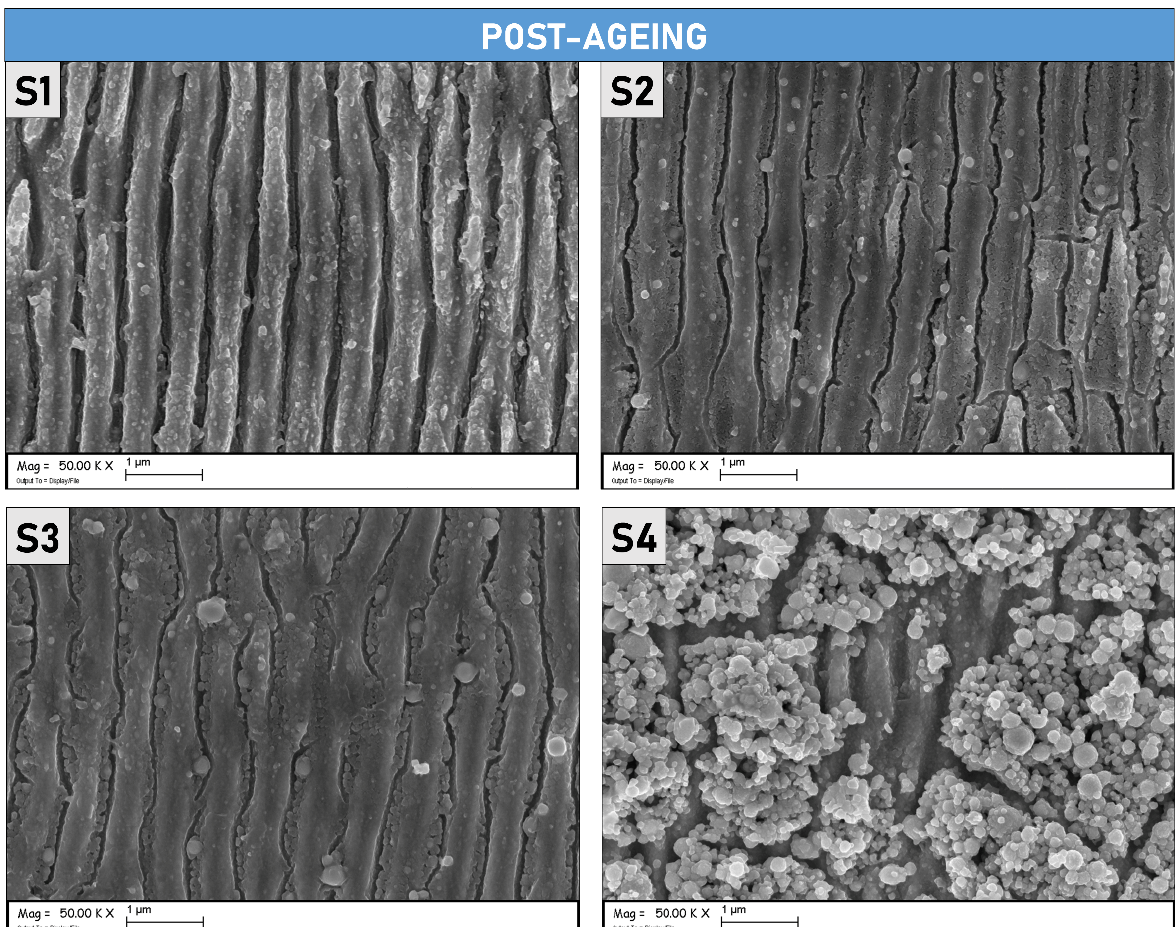
Figure 10. SEM micrographs (magnification 50 k×) of the four different Mo samples after thermal ageing.